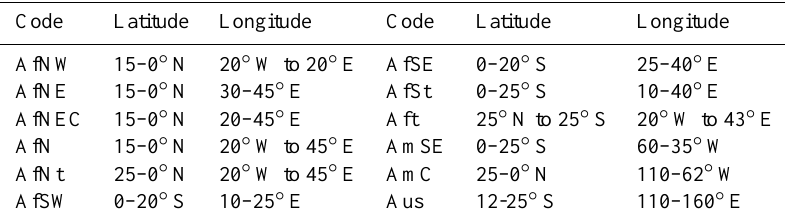
Figure 6. Evolution of the day–night difference of the integrated content of CO from IASI on land, and of fires, on average over 2008–2011 on different areas in southern Africa (see Fig. 5). Red: day–night CO. Black dashed: MODIS Burned Areas. Purple dashed: CO emissions from GFED3.1. Green dashed: CO emissions from GFAS1.0. Table 2. Coordinates of the studied areas in the tropics, corresponding to Fig. 7. Af, Am and Aus respectively stand for Africa, America and Australia. N, S, E and W respectively stand for north, south, east and west, and t stands for